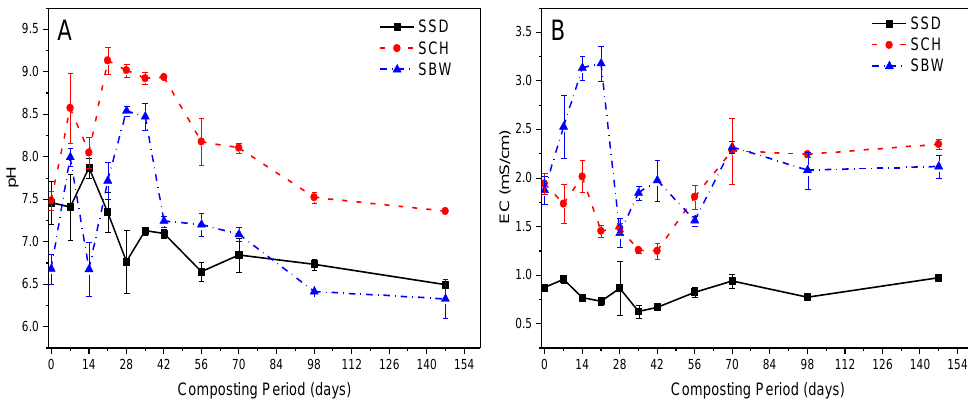
Figure 2. Evolution of: ( A ) pH; and ( B ) electrical conductive (EC) during the composting of Faecal Sludge-FS with Brewery waste-SBW, Coffee husks-SCH, and Sawdust-SSD with different bulking agents. Error bars represent the standard error of n = 2.